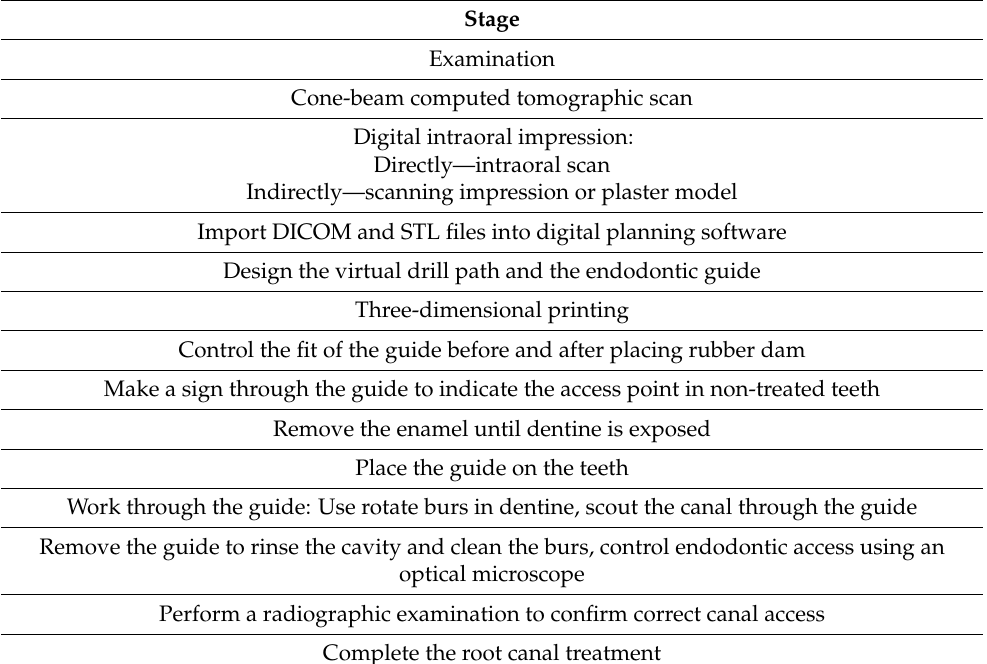
Table 1. Digital and clinical workflow of guided